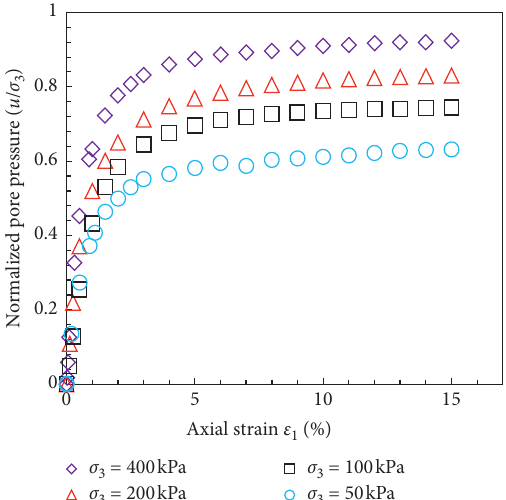
Figure 6: Normalized pore pressure (u/ σ 3 )-axial strain curves of gravelly sand under CTC (CU) stress